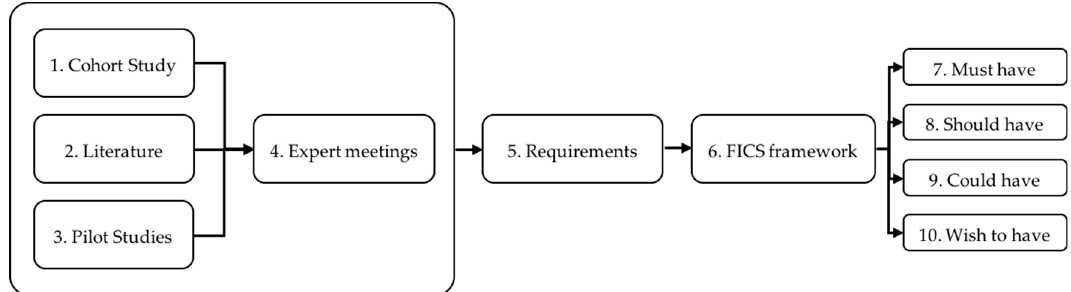
Figure 1. Requirements were formulated from insights gathered in the Diabetes and Lifestyle Cohort Twente (DIALECT) cohort study ( 1 ), literature research ( 2 ) and pilot studies ( 3 ). In expert meetings ( 4 ) these requirements were discussed and new requirements ( 5 ) were added. The requirements were formulated according to the Function and events, Interactions and usability, Content and structure and Style and aesthetics (FICS) framework ( 6 ). The requirements were labelled during expert meetings as “must” ( 7 ), “should” ( 8 ), “could” ( 9 ), and “wish to” ( 10 ) have.